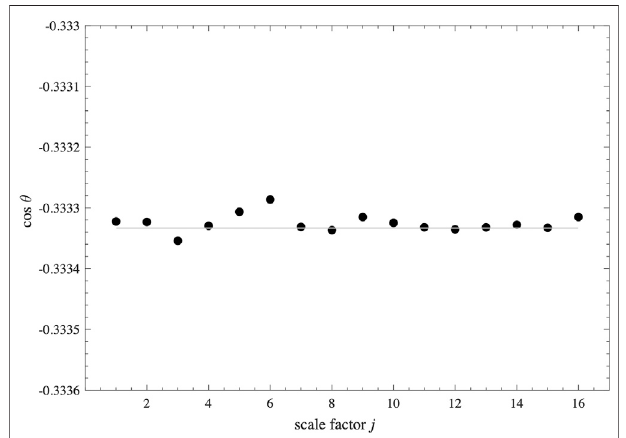
FIGURE 1 | The computed average external dihedral angle of boundary tetrahedra as function of the scale factor. The gray line shows the dihedral angle of a regular